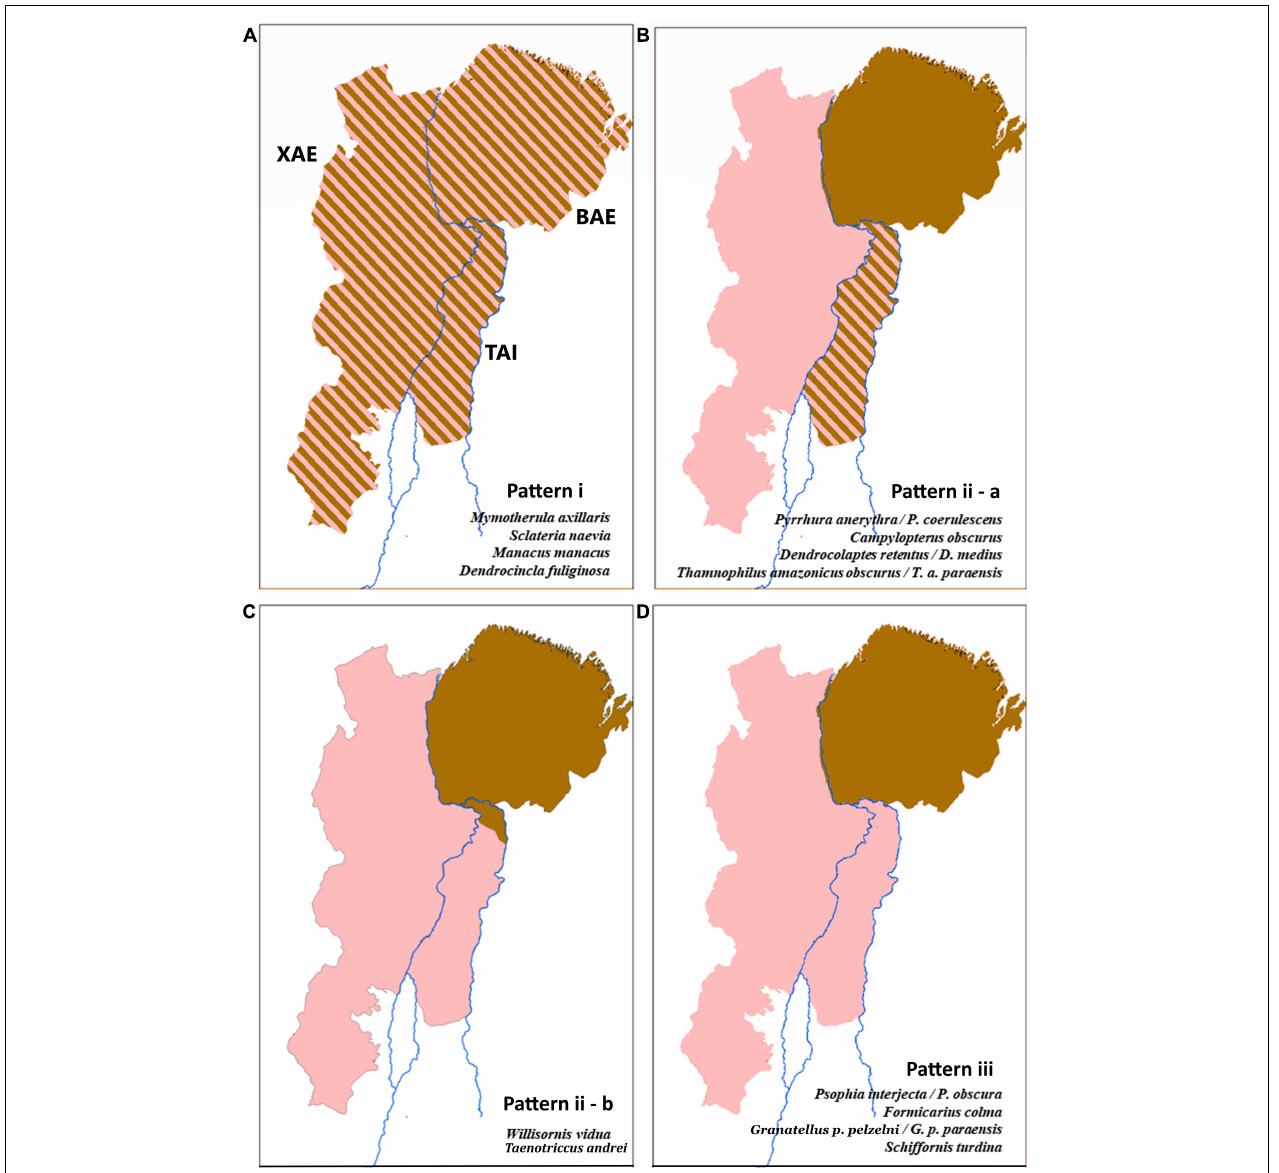
FIGURE 2 | Phylogenetic and haplotype network analyses and Fst indexes revealed three distinct phylogeographic patterns shared by genetically sampled avian lineages in the TAI, as follows: pattern i (A) , no population structure across the Xingu Area of Endemism (XAE), TAI, and Belem Area of Endemism (BAE); pattern ii, two clades associated each with XAE and BAE, with TAI populations grouping in both clades, but with two alternative spatial distributions, defined as “a” – TAI as a contact zone with evidence of gene-flow and sympatry between distinct species/phylogroups inhabiting XAE and BAE (B) , and “b” – two distinct phylogroups without evidence of gene-flow, associated with XAE and BAE and distributed in a parapatric fashion within the TAI (C) ; and pattern iii (D) , the Tocantins River as the barrier isolating BAE phylogroups from those inhabiting both TAI and XAE. See Supplementary Material for